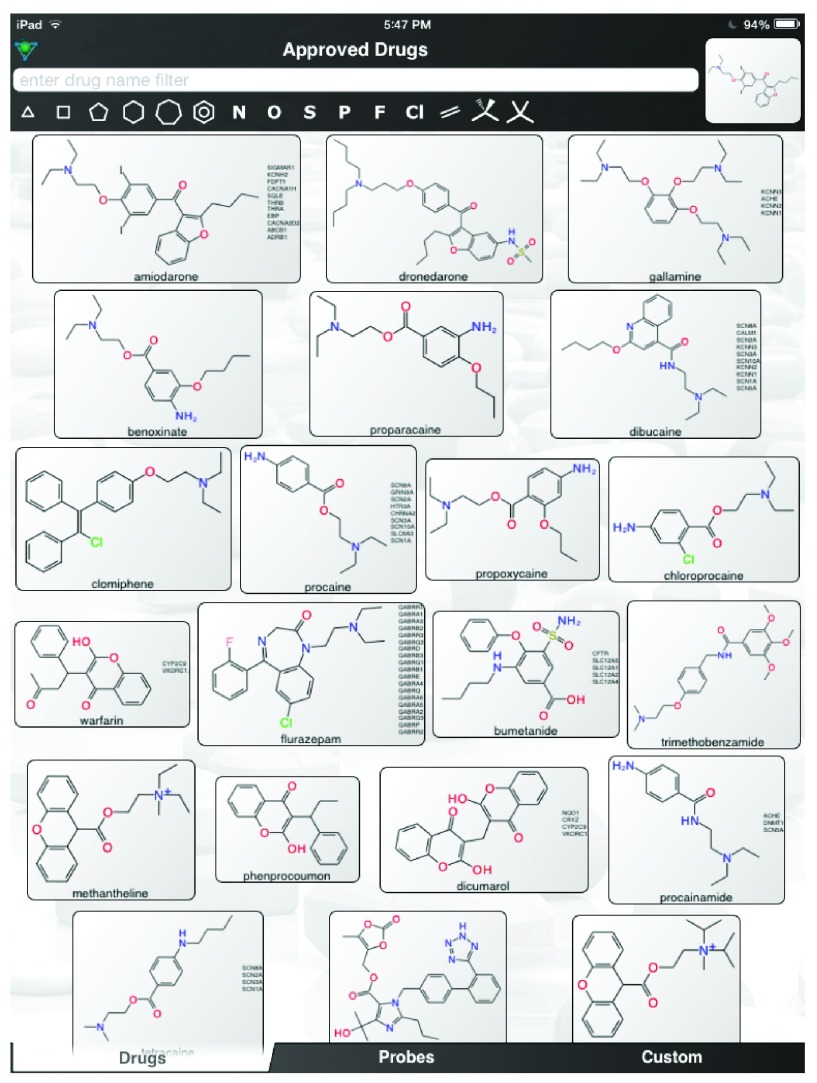
Amiodarone similarity in Approved drugs mobile app
http://molmatinf.com/approveddrugs.html.